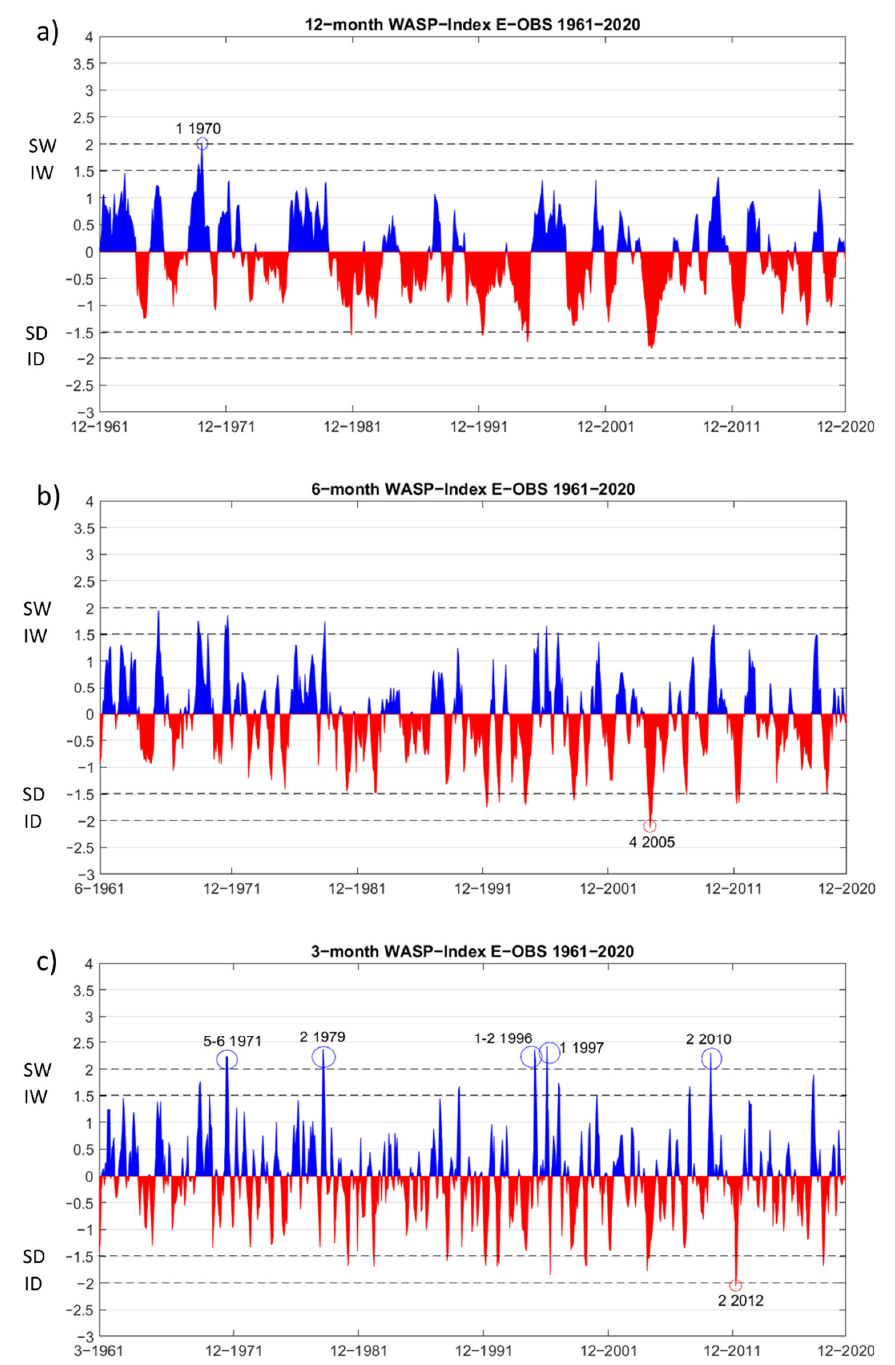
Figure 3. Area-mean values between 1961–2070 for ( a ) 12m-WASP, ( b ) 6m-WASP and ( c ) 3m-WASP- Indexes in which intermediate-to-severe dry (red) and wet (blue) events are identified (months and year). and